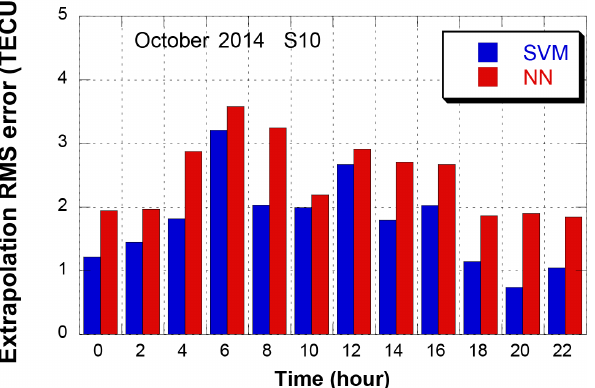
Figure 13. Extrapolation RMS errors for each 2h interval on Octo- ber 2014 (south 10 ◦